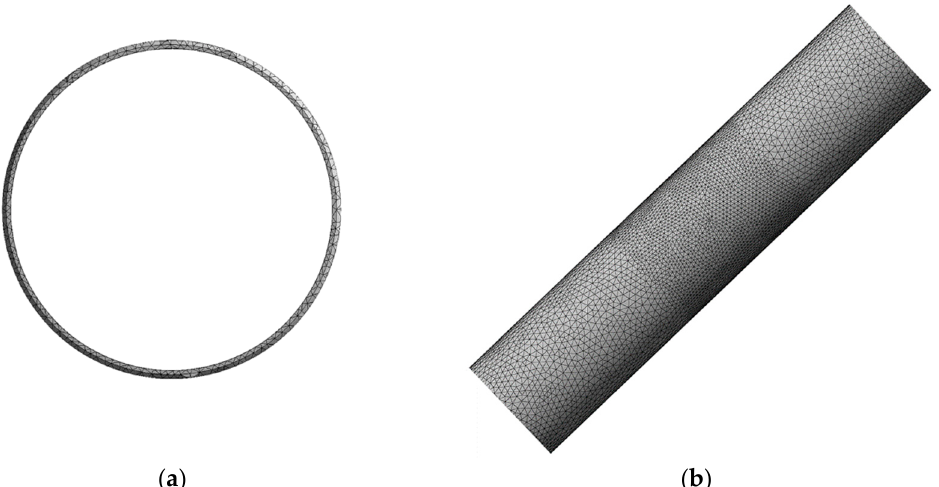
Figure 5. Computational mesh for the solid domain: ( a ) mesh in the entrance plane; ( b ) mesh near the impact region.